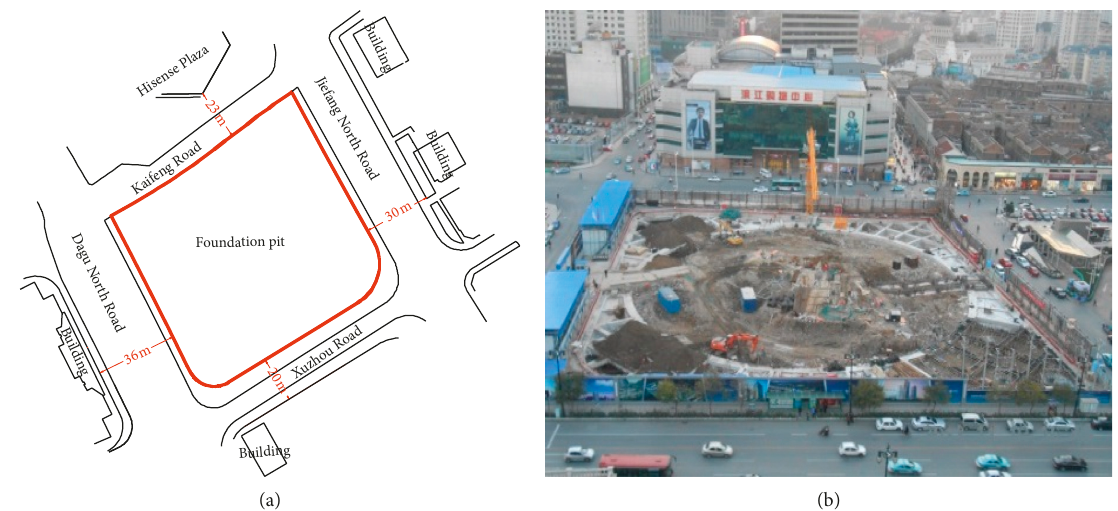
Figure 1: Plan view illustrating the position and site photo of the foundation pit. (a) Plan view. (b) Site photo. Table 1: Physical and mechanical parameters.